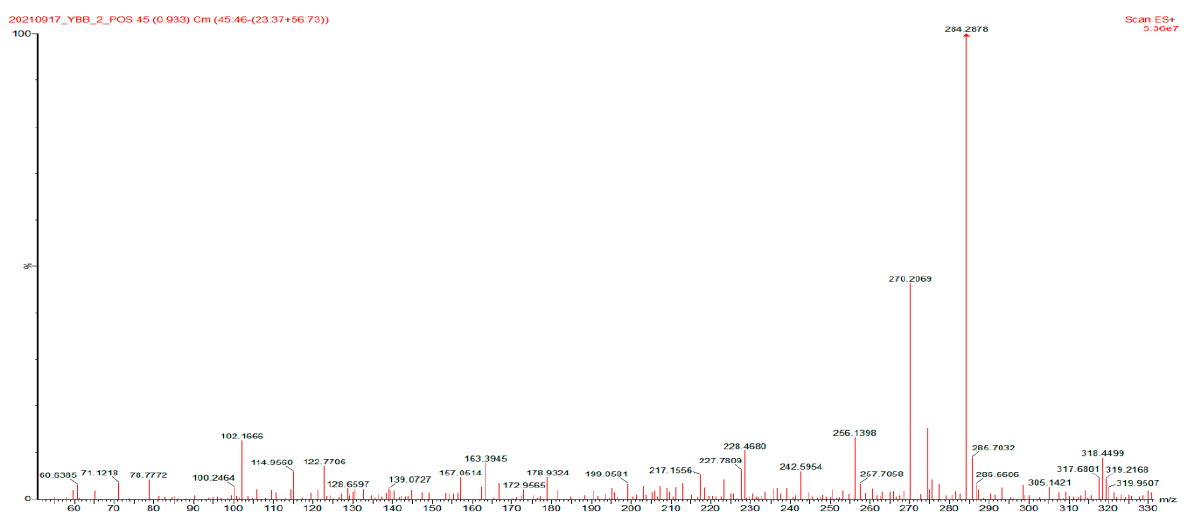
Figure 10. LCMS spectrum showing compounds identified in the MB solution after photocatalytic oxidation.